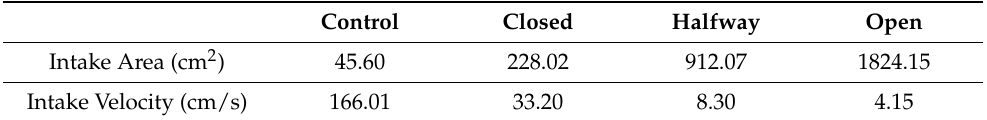
Table 1. Intake areas and